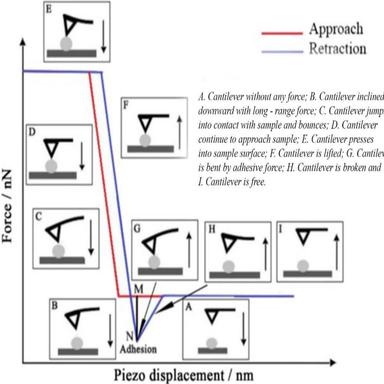
The adhesion force between magnetic nanoparticles and the substrate surface.